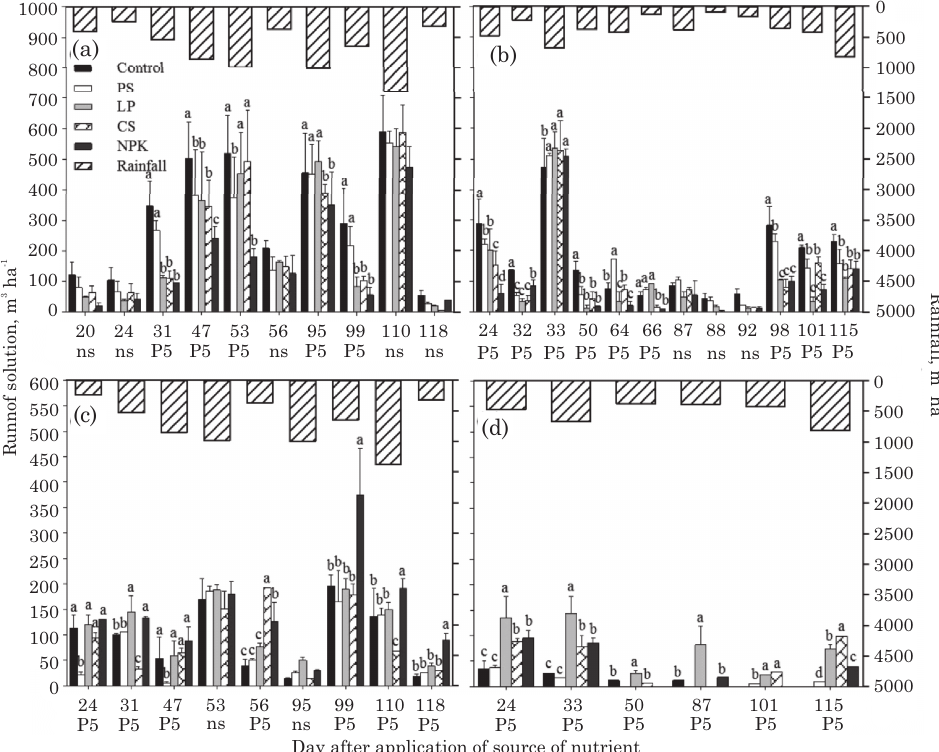
Figure 2. Volume of rainfall, runoff solution on the soil surface from black oat (a) and maize (b) and volume of the leached solution from black oat (c) and maize (d), in a Typic Hapludalf treated with nutrient sources. P5: significant at 5 % probability by the Scott-Knott test; ns: not significant at 5 % probability.